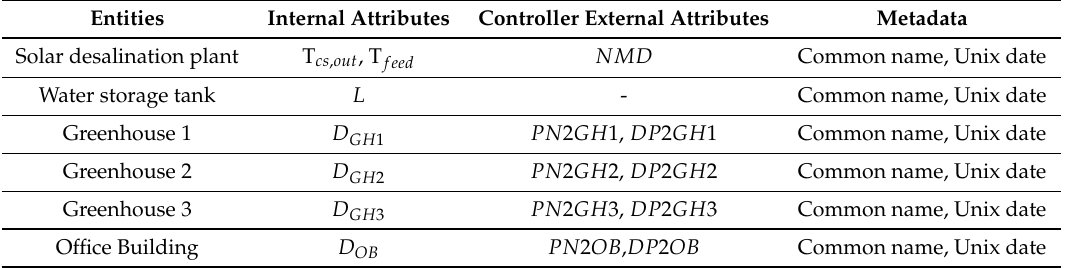
Table 1. Entities of OCB FIWARE required for MPC